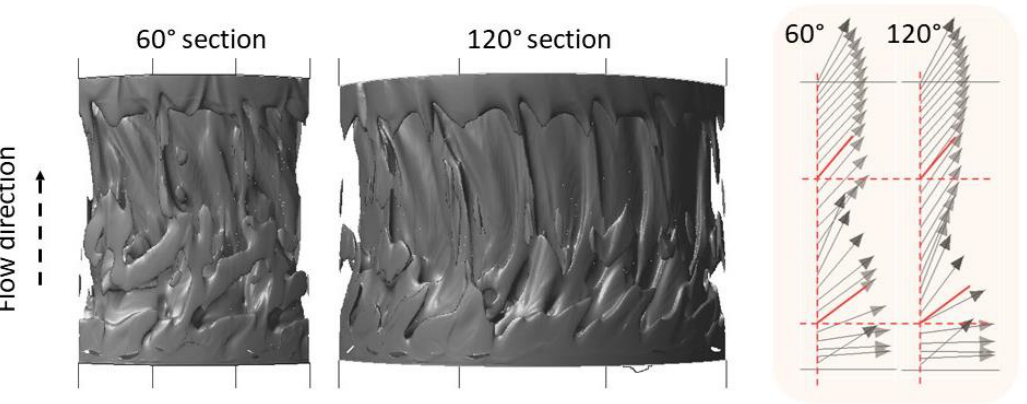
Figure 5. Comparison of results from TCP flow simulations in a smooth air gap that represent the impact of the computational domain span on flow development. The iso-surfaces with a 𝜆–2 value of 1500 1/s 2 are depicted on the left, and average velocity vectors near the rotor surface are shown on the